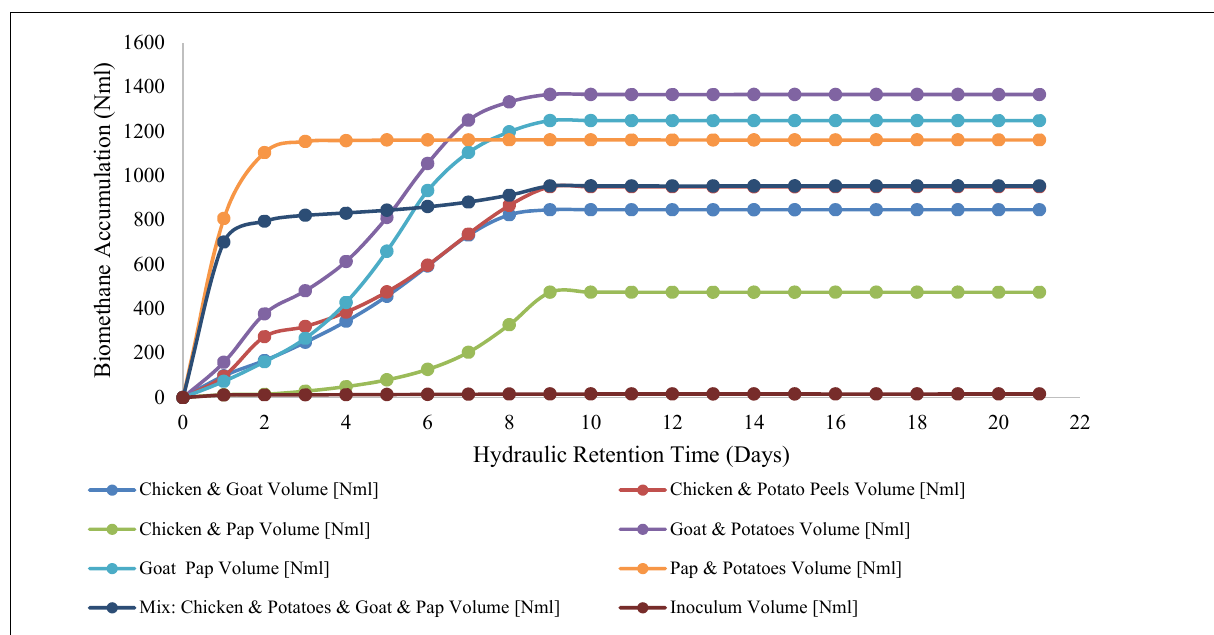
Figure 7: Biomethane production through co-digestion of